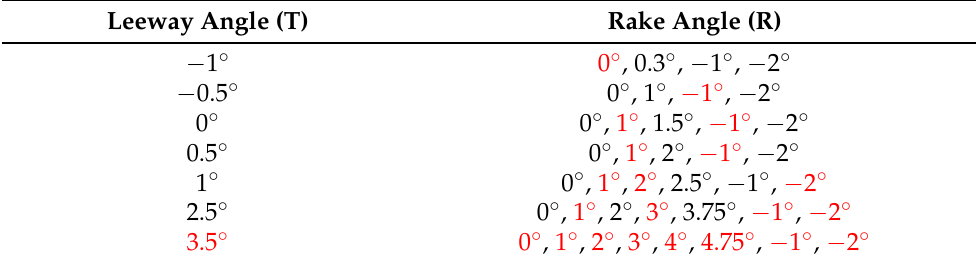
Table 6. Test matrix used in the experiments, the complete set shown in red and black, and in the numerical simulations, highlighted in black, at 9 m/s.